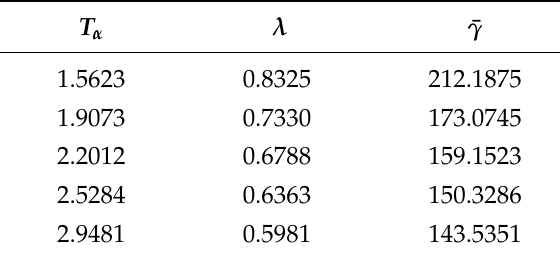
Table 3. λ and ¯ γ for various T α with given τ D = 333.